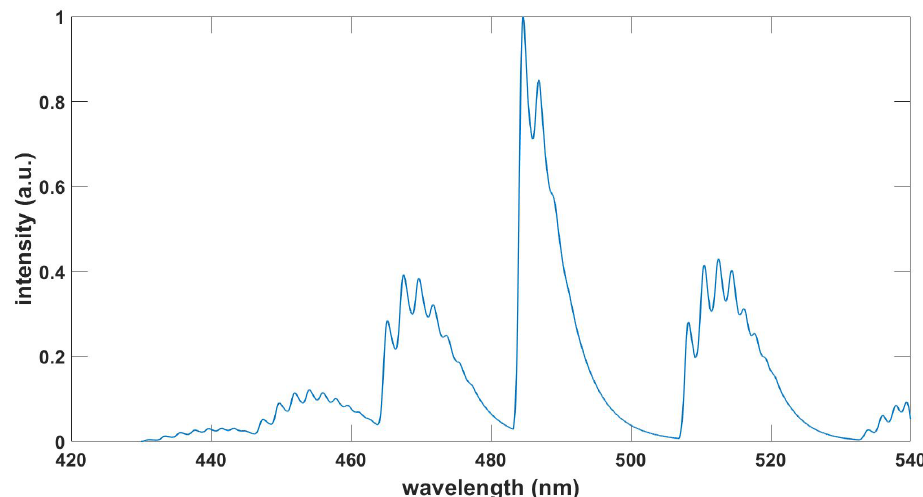
Figure 1. Computed AlO spectrum, ∆ v = 0, ± 1, ± 2, + 3, δ λ = 1.0nm, T = 3.33